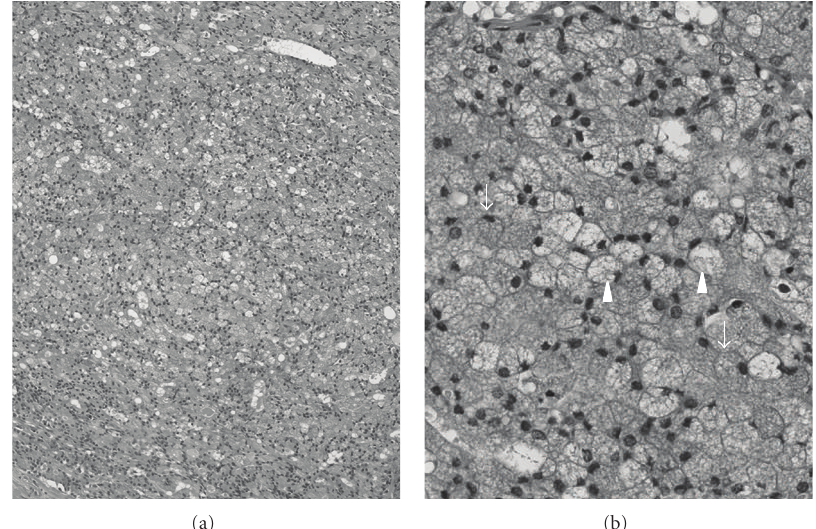
Figure 3: (a) The acinar cells have proliferated in sheet-form, and the tumor is classified as the solid-growth pattern (H&E stain, original magnification 100X). (b) An acinar cell (arrow) shows violet staining of the cytoplasm and an eccentrically positioned nucleus, while the cytoplasm of a vacuolated cell (arrowhead) is seen to be filled with vacuoles (H&E stain, original magnification 400X).